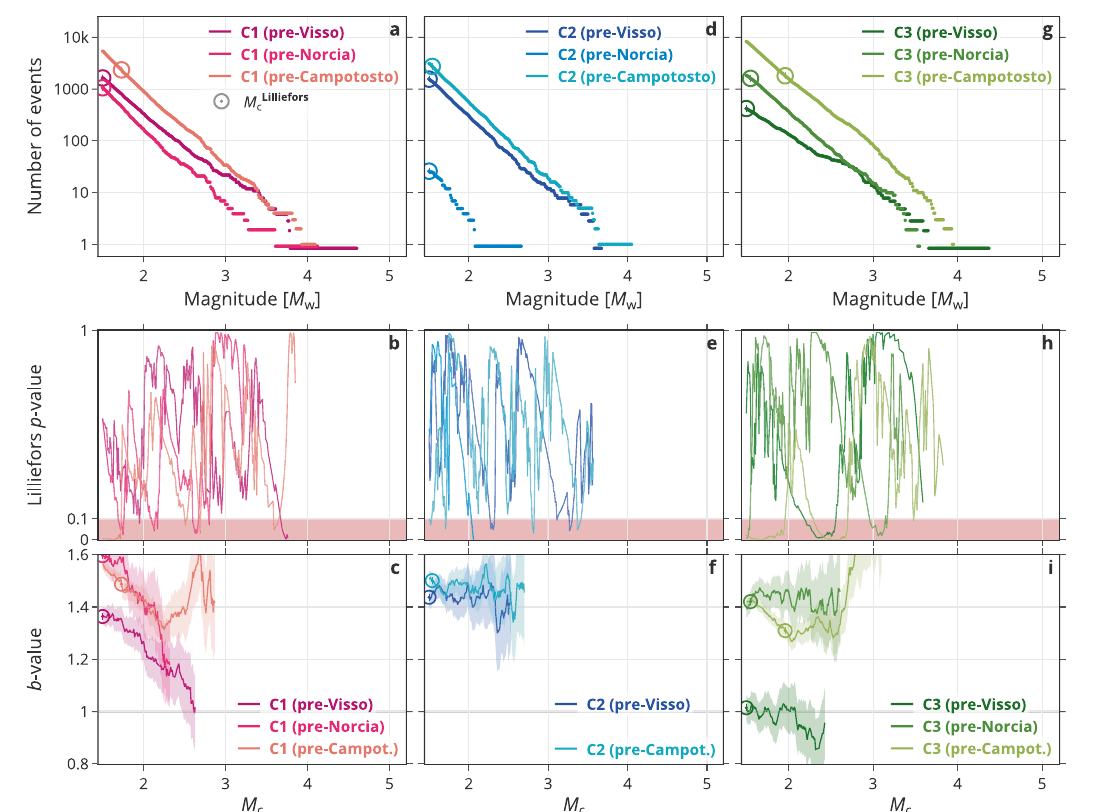
Fig. 4 | Magnitude statistics of the three largest clusters in three individual periods. a – c Cluster1, d – f Cluster 2,and g – i Cluster3. Like Fig. 3, a , d , and g show clusters in terms of their magnitude – frequency distribution; b , e , and h show the Lilliefors p -value asfunction of M c ; and c , f , and i the b -value asfunction of M c with